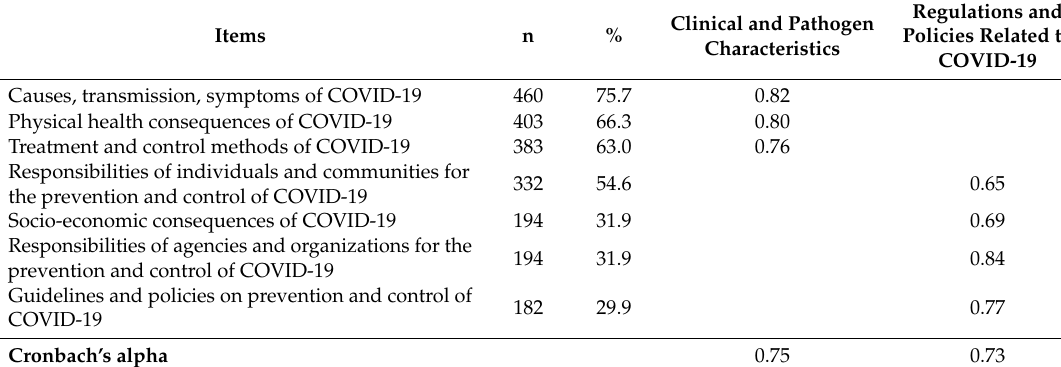
Table 3. Contents of information obtained by